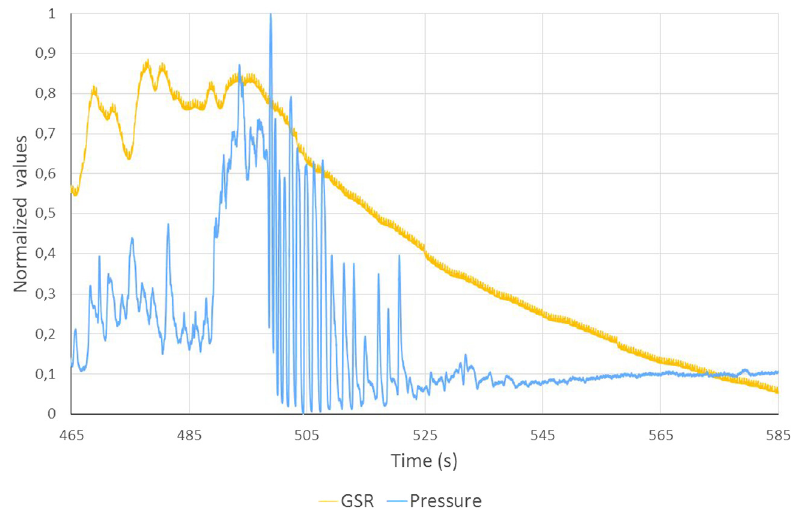
Figure 20: Pressure of internal anal sphincter and GSR normalized.